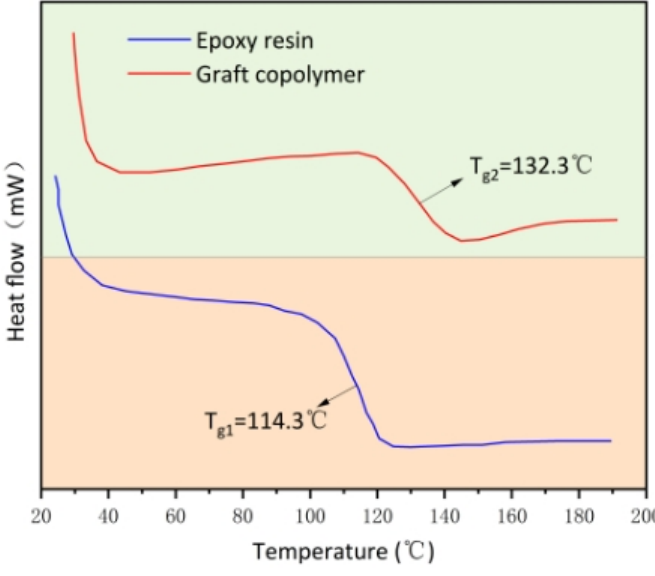
Figure 9. DSC curve of the epoxy resin and graft copolymer.